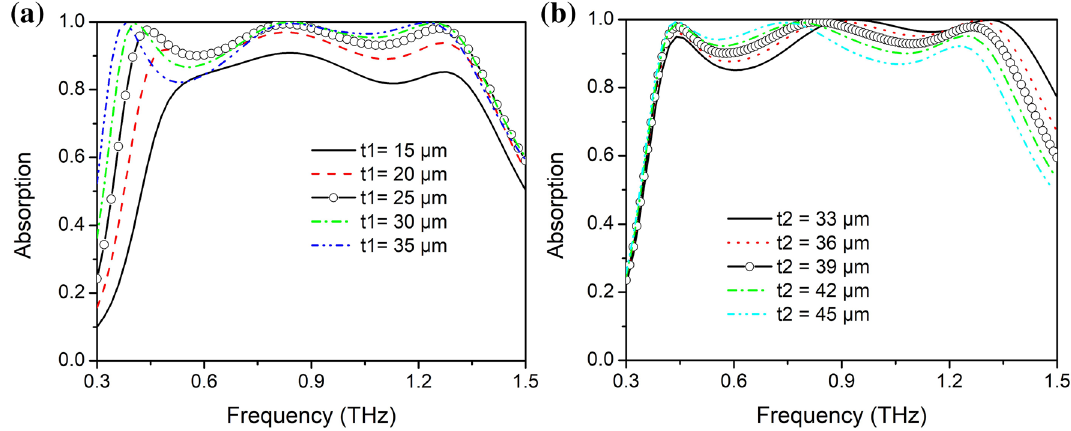
Figure 4. Absorption spectrum modification with thickness of SiO 2 layers t 1 ( a ) and t 2 ( b